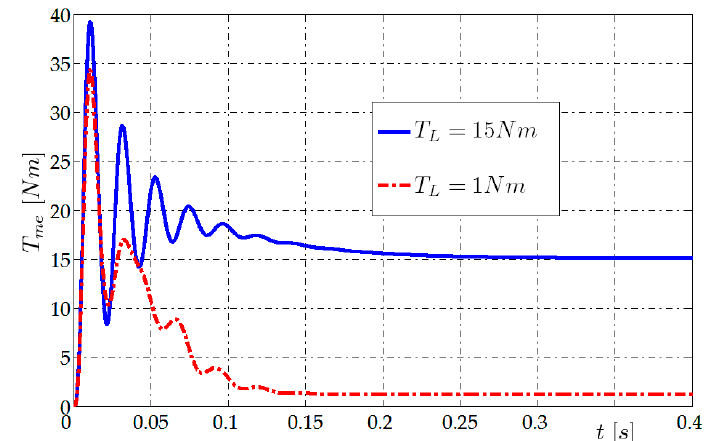
Figure 11. The electrical torque during the start ‐ up motor for different load torque.